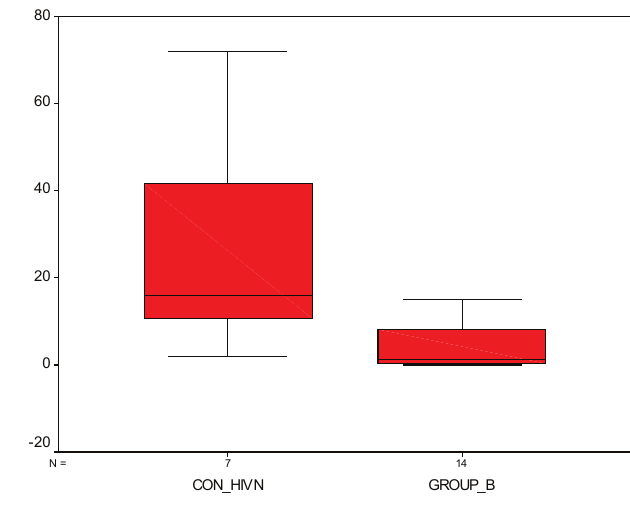
FIGURE 2 – Boxplot – Comparison of Langerhans cell populations between HIV-negative control group and Group